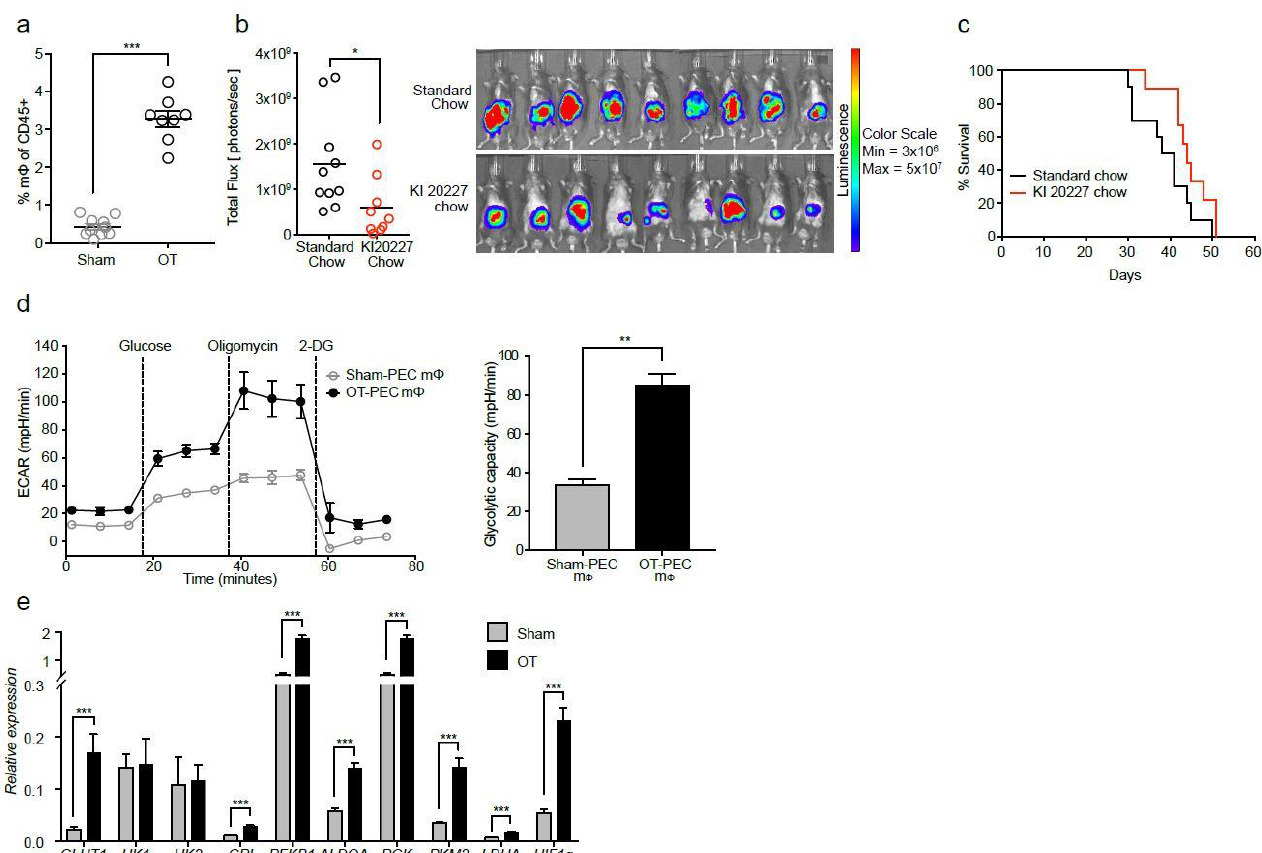
Figure 1. Macrophages from tumor-bearing mice are highly glycolytic. ( a ) Pancreata from Day 28 tumor-bearing orthotopically-transplanted (OT) mice were assessed for their myeloid cell populations by flow cytometry. Scatter plot of macrophages (CD45+ Lin- MHCIIlow-int CD24+ CD11b+ Ly6G- Ly6Clow F4/80+) that infiltrate the pancreas/tumor, as a percentage of total CD45+ cells, from OT (black) and age-matched sham controls (grey) (sham, n = 10; OT, n = 8, three independent experiments pooled). ( b ) OT mice were fed either KI20227 250 ppm (red) or standard rodent chow (black) beginning Day 1 of tumor cell transplantation. Representative scatter plot of the total flux on Day 26 as calculated from the BLI image shown (KI20227, n = 9; control, n = 10, two independent experiments). BLI images for all figures were acquired at 15-s exposure, and color scale set with lower limit at 3 × 10 6 and upper limit at 5 × 10 7 photons/sec. ( c ) Kaplan–Meier survival analysis of KI20227-fed mice ( n = 9) compared with standard chow-fed mice ( n = 10). ( d ) Sorted peritoneal (PEC) macrophages from OT and sham control mice were rested at 37 ◦ C for 1 h and assessed for their glycolytic capacity in a live metabolic flux assay. Shown is a representative Seahorse trace of OT-PEC macrophages (black) compared with sham (grey) ( d ), and a bar graph of glycolytic capacity as calculated from the Seahorse trace ( n = 3 mice pooled per group, five independent experiments). ( e ) PEC macrophages from OT and sham controls were assessed at the transcript level for GLUT1, HK1, HK2, GPI, PFKB1, ALDOA, PGK, PKM2, LDHA, and HIF1 α ( n = 3 mice pooled per group, three independent experiments). Data are means ± SEM, * p < 0.05; ** p < 0.01; *** p < 0.001 by unpaired student’s t-test with 95% confidence